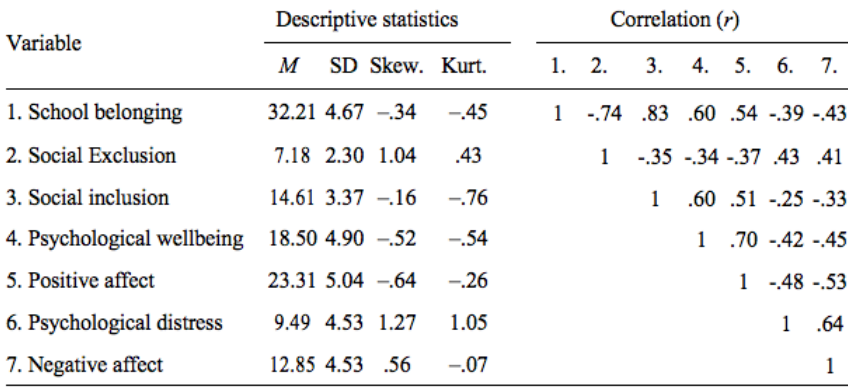
Results of Descriptive Statistics and Correlations (r)